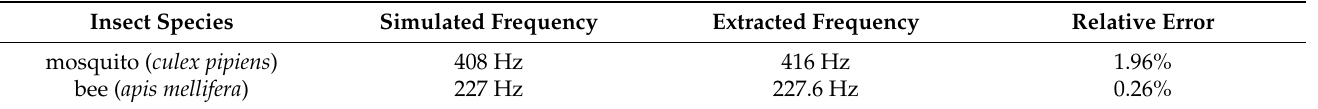
Table 4. Error analysis between simulated and extracted